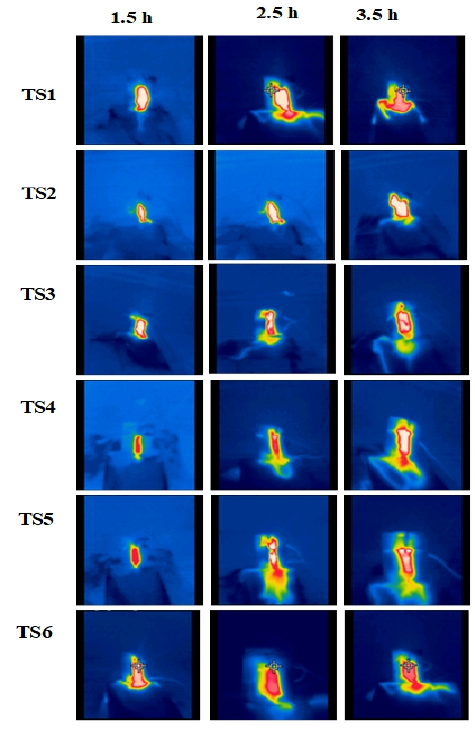
Figure 12. IR images of the multi ‐ stress ‐ aged samples from TS1 to TS6.